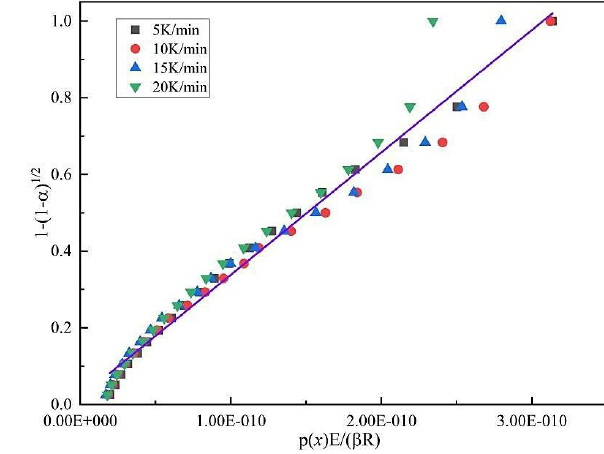
Figure 5: Master-plots of theoretical g ( α )/ g (0.5) vs α for A1, A1/2, R2, D5, P1, and C1 reaction models and experimental master-plots for carbothermal reduction of phosphate rock with particle size